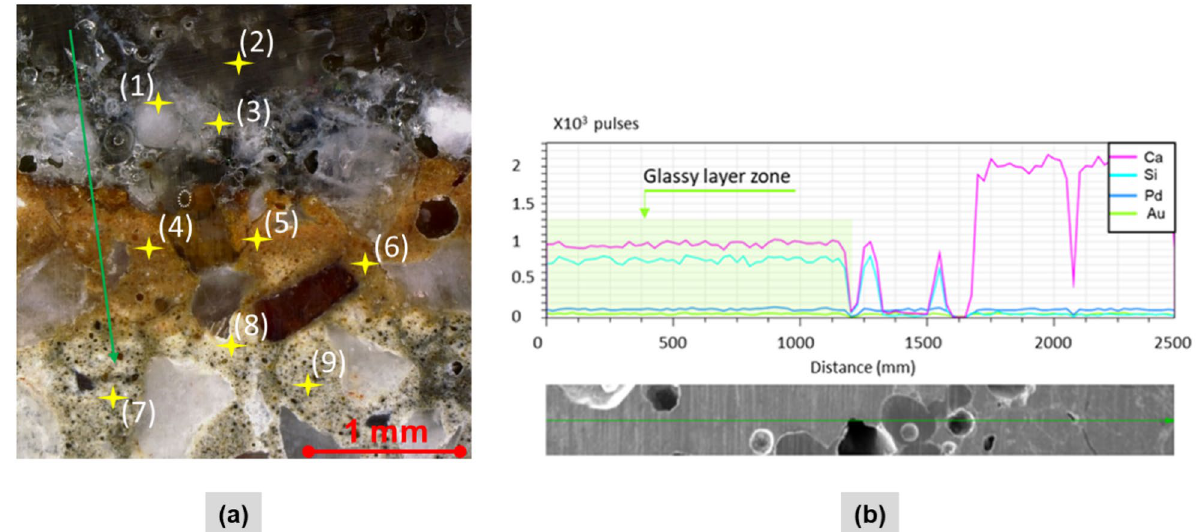
Figure 15. ( a ) Chosen points for chemical analysis in the cross-section, ( b ) Identification of the glassy layer based on the EDX line